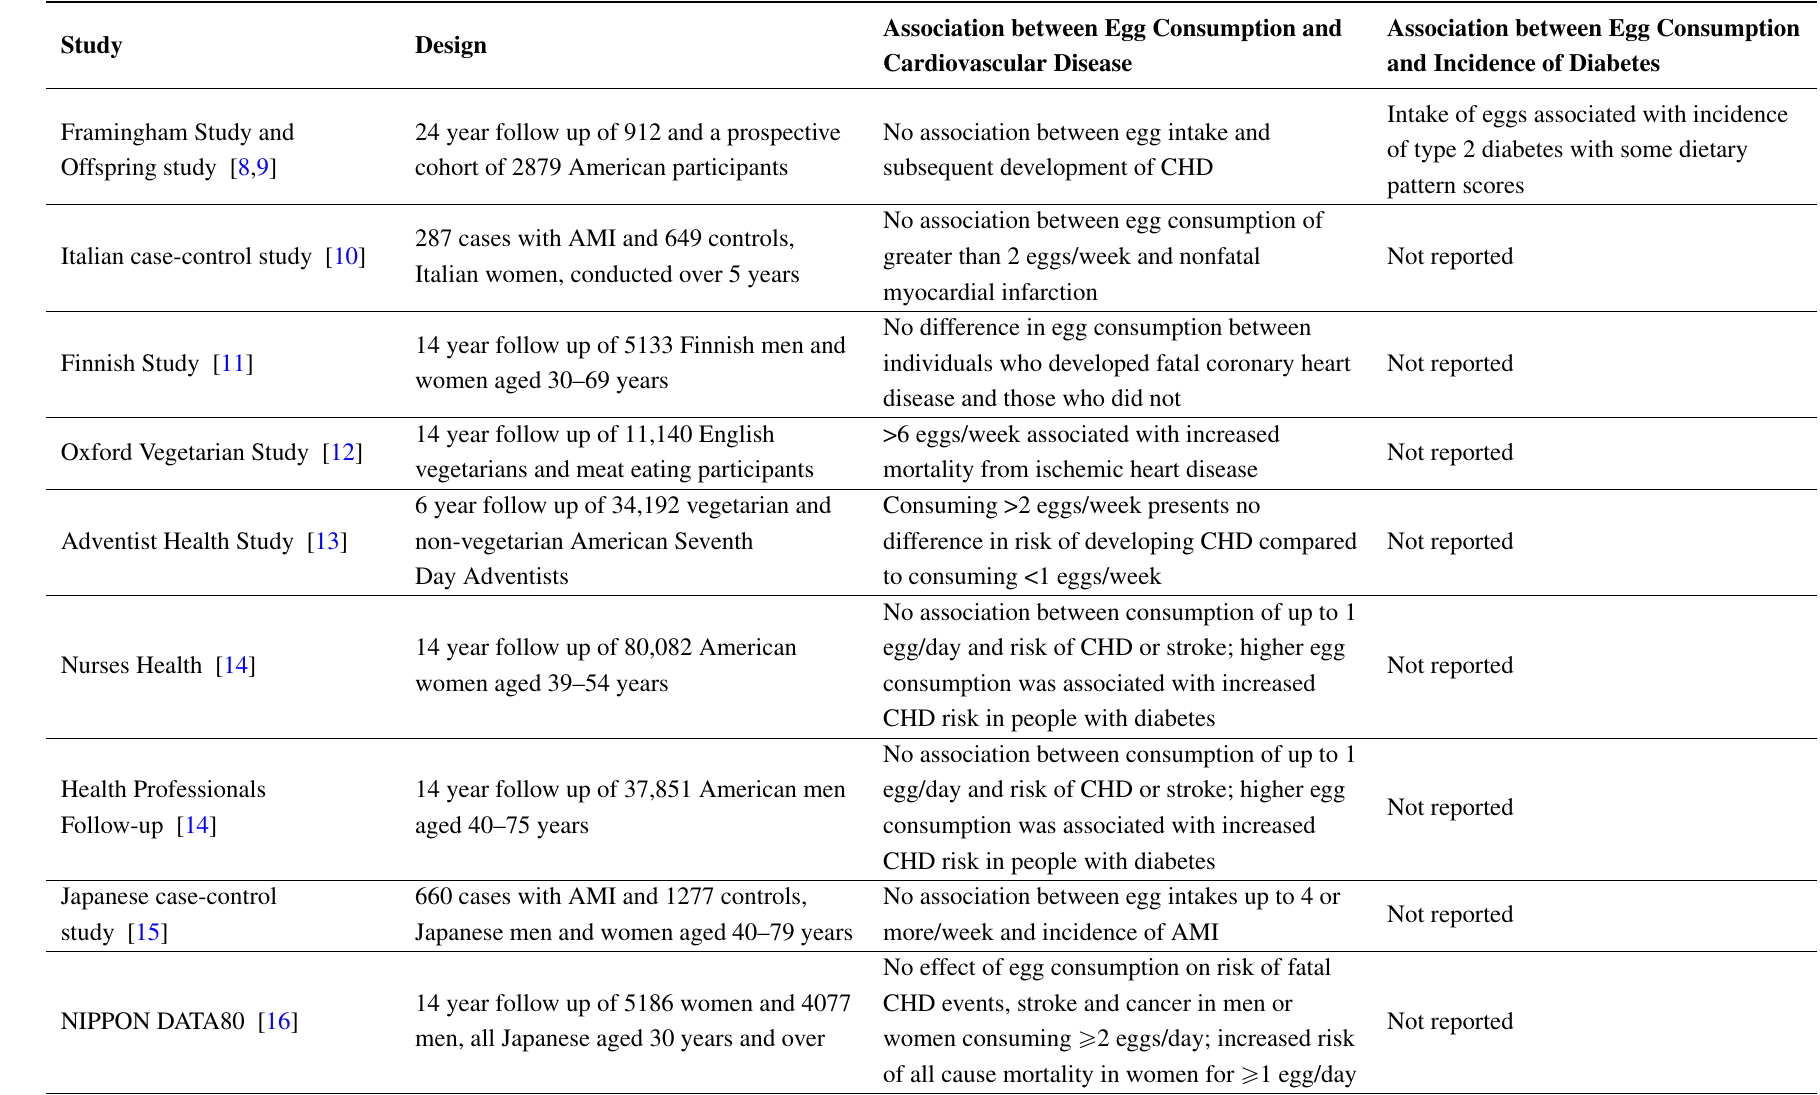
Table 1. Summary of epidemiological evidence regarding egg consumption, cardiovascular disease, and incidence of